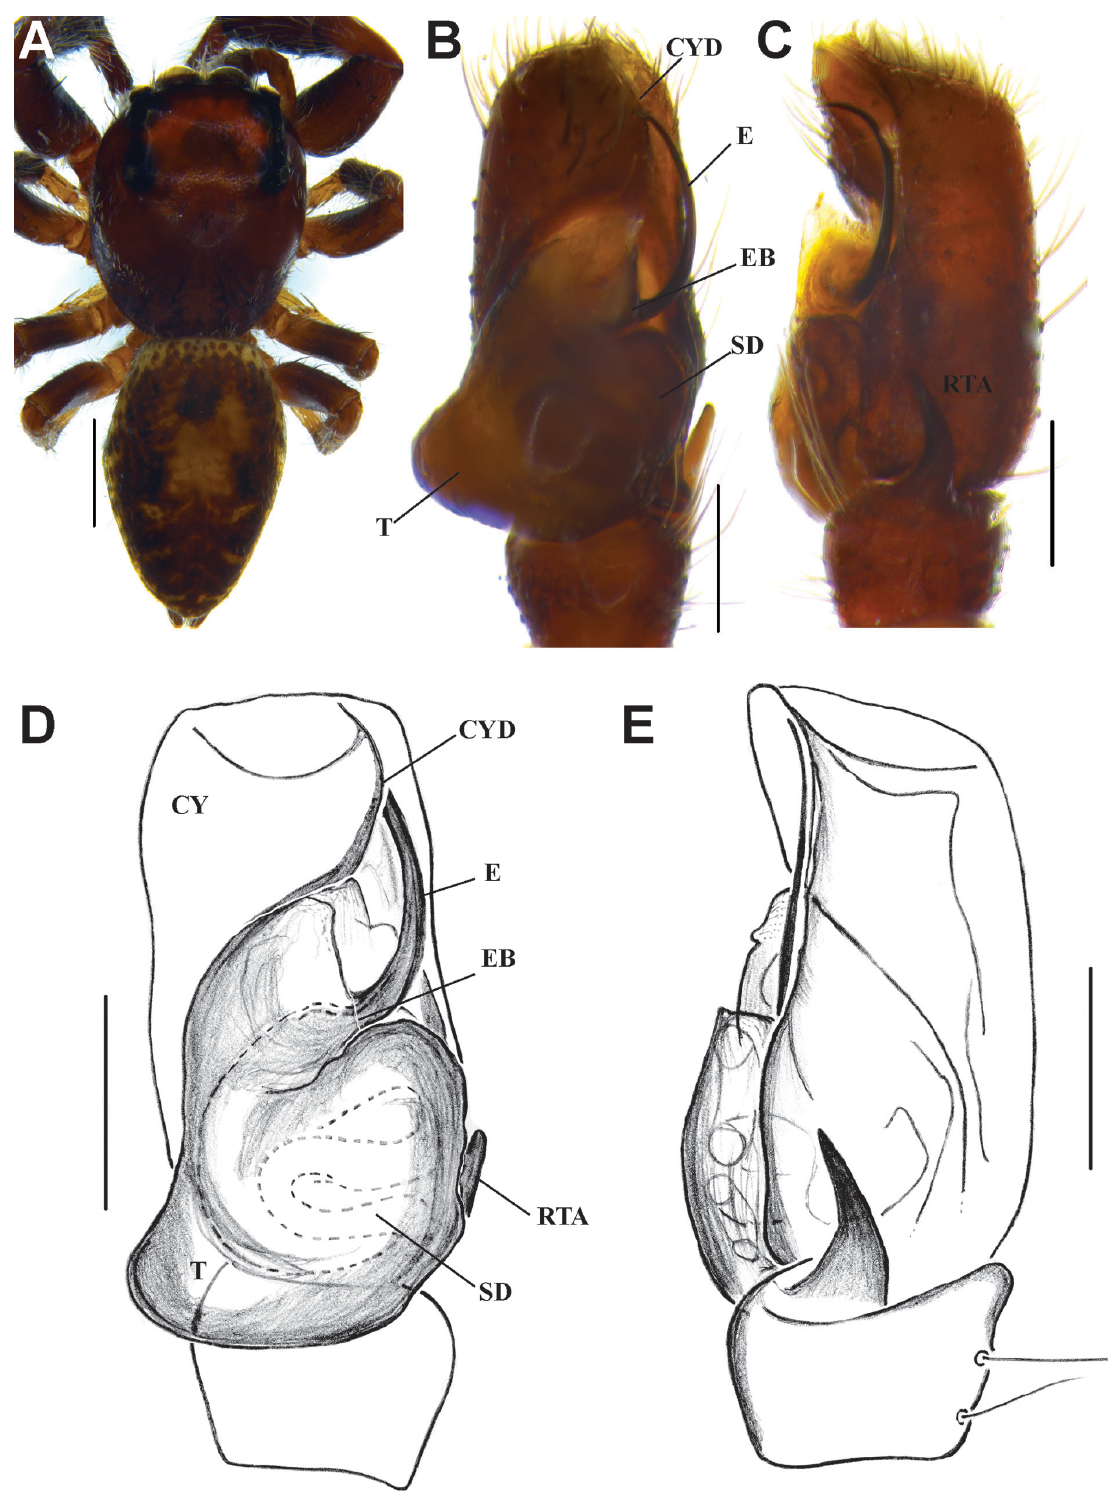
Fig. 10. Macaroeris nidicolens (Walckenaer, 1802) . A . ♂, habitus, dorsal view. B, D . Palp, ventral view. C, E . Palp, retrolateral view. Abbreviations: CY = cymbium; CYD = cymbial depression; E = embolus; EB = embolic base; RTA = retrolateral tibial apophysis SD = sperm duct; T = tegulum. Scale bars: A = 1 mm; B–E = 0.2